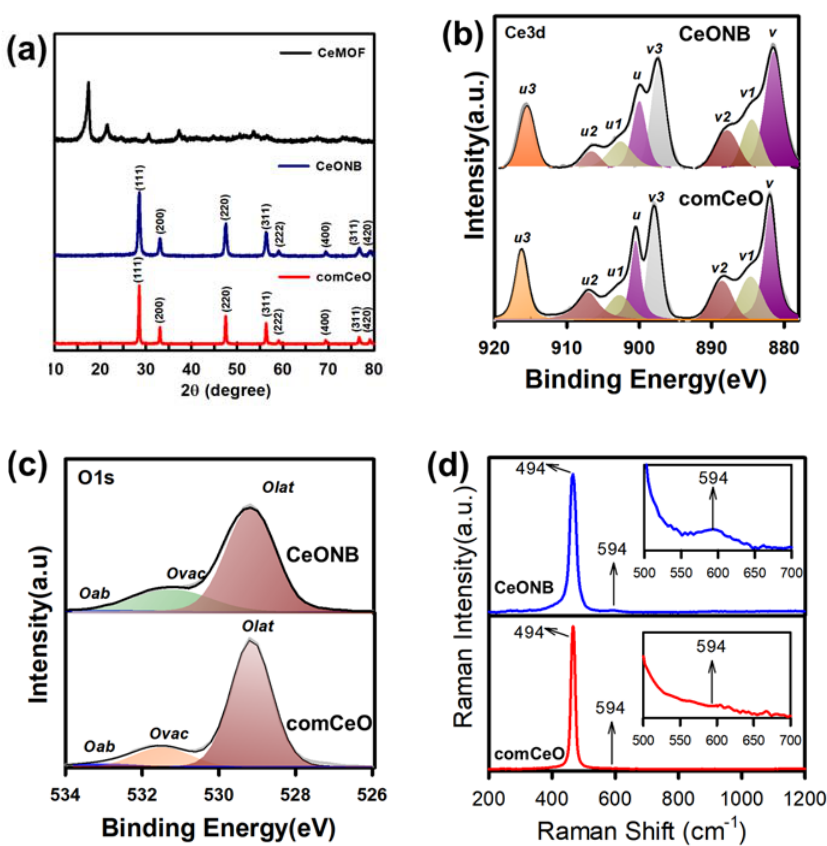
Figure 4. ( a ) XRD patterns of Ce − MOF, CeONB, comCeO; and XPS analyses of CeONB and comCeO: ( b ) Ce3d and ( c ) O1s; ( d ) Raman spectra of CeONB and comCeO.